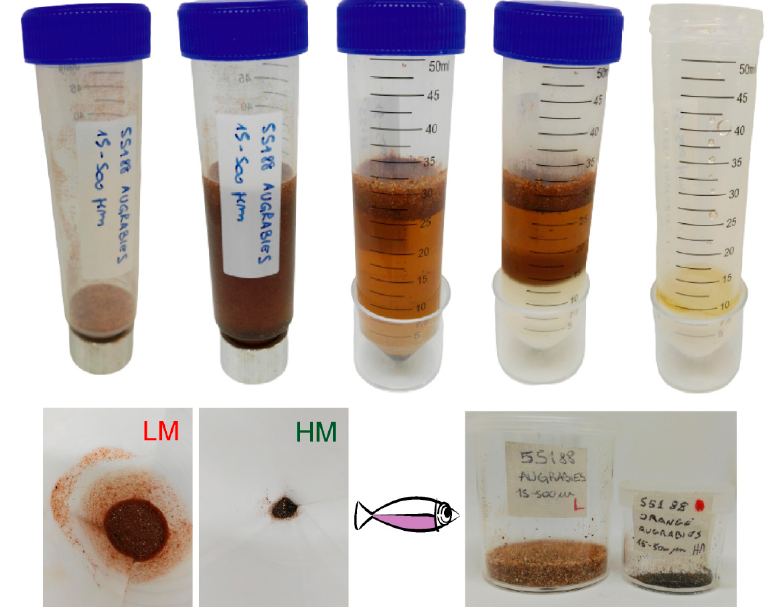
Figure 5. Gravimetric separation sequence with SPT and conic tubes, to separate the dense and light fractions in a centrifuge. From left to right in the first line: initial dry sample, sample mixed with SPT after shaking, the light minerals (LM) and the heavy minerals (HM) separated by SPT after the centrifugation, sample with frost-heavy fraction in the bottom and unfrozen light fraction in the top of the conic tube, and empty conic tube after recovering of the light fraction with the heavy minerals still in the ice. Second line: washed light minerals in the paper filter, washed dark heavy minerals in the paper filter, and light and heavy minerals dried and stored and labeled in plastic boxes after weighing. The lower part of the test tube is defrosted by adding deionized water, and the dense fraction is recovered in another folded, properly labelled paper filter, washed with 0.3–0.5 L deionized water (more where dense grains are particularly abundant). The diluted SPT is recovered in glass beakers. For each sample, the two paper filters containing the low-density and dense fractions are folded, closed with a peg, and placed to dry in oven at 40–60 °C overnight. The dried fractions are both weighed with a precision balance with four decimals, and weights are noted on an appropriate data sheet (Table 1).